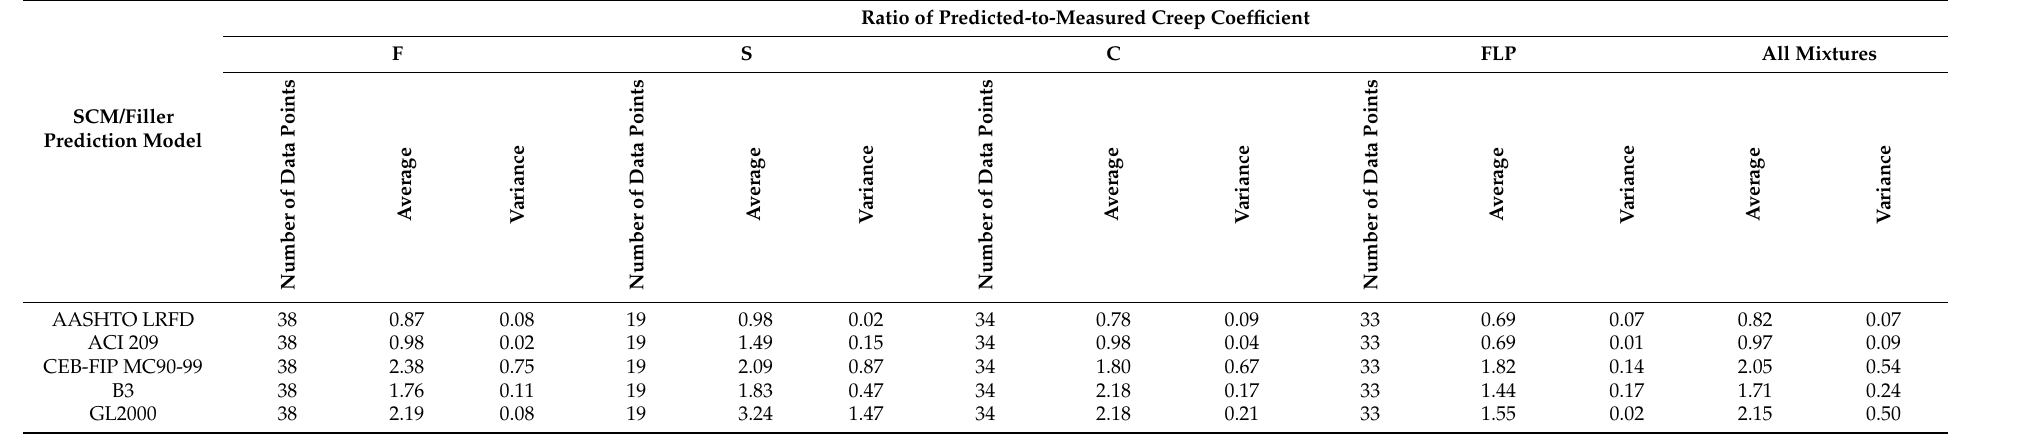
Table 8. Statistical analysis results of creep predictions for SCC with different types of